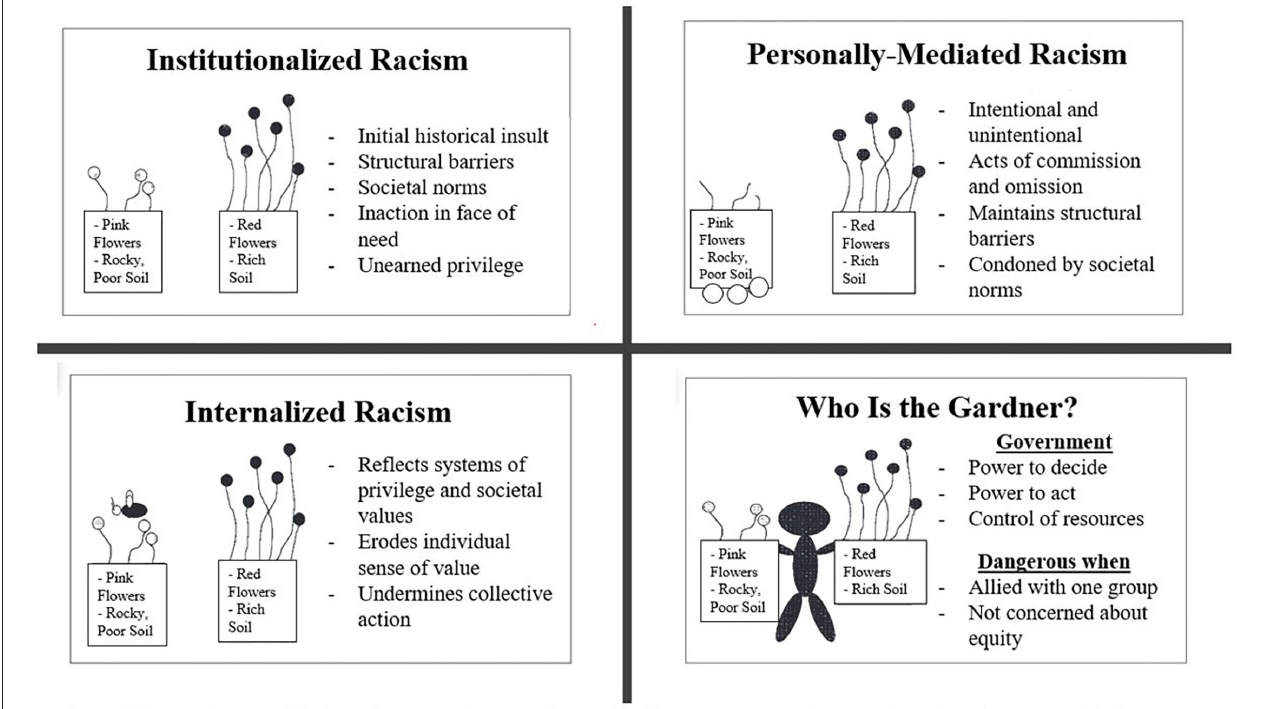
FIGURE 1 | Adaptation of the Gardener’s Tale. Adapted from Jones